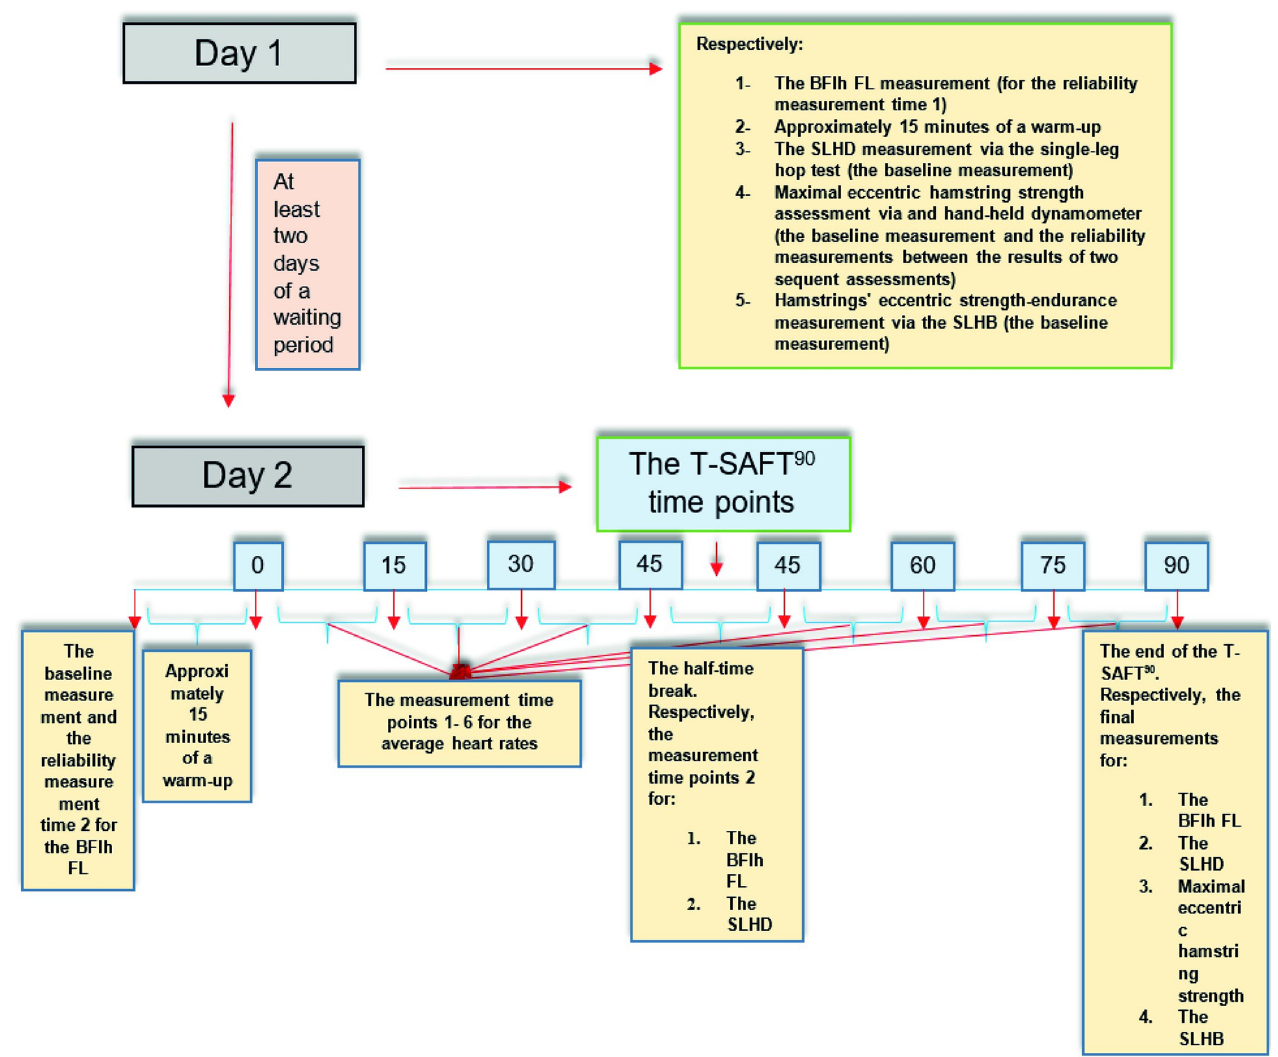
Fig 1. Study flow diagram. This diagram shows the actions taken in the first and second sessions of the